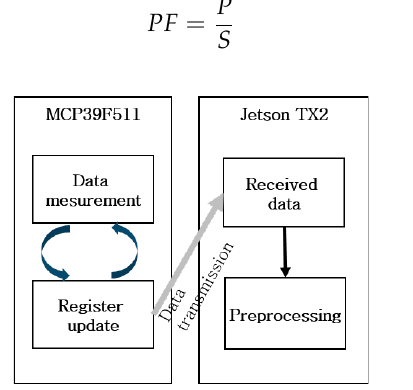
Figure 3. Data transfer process.